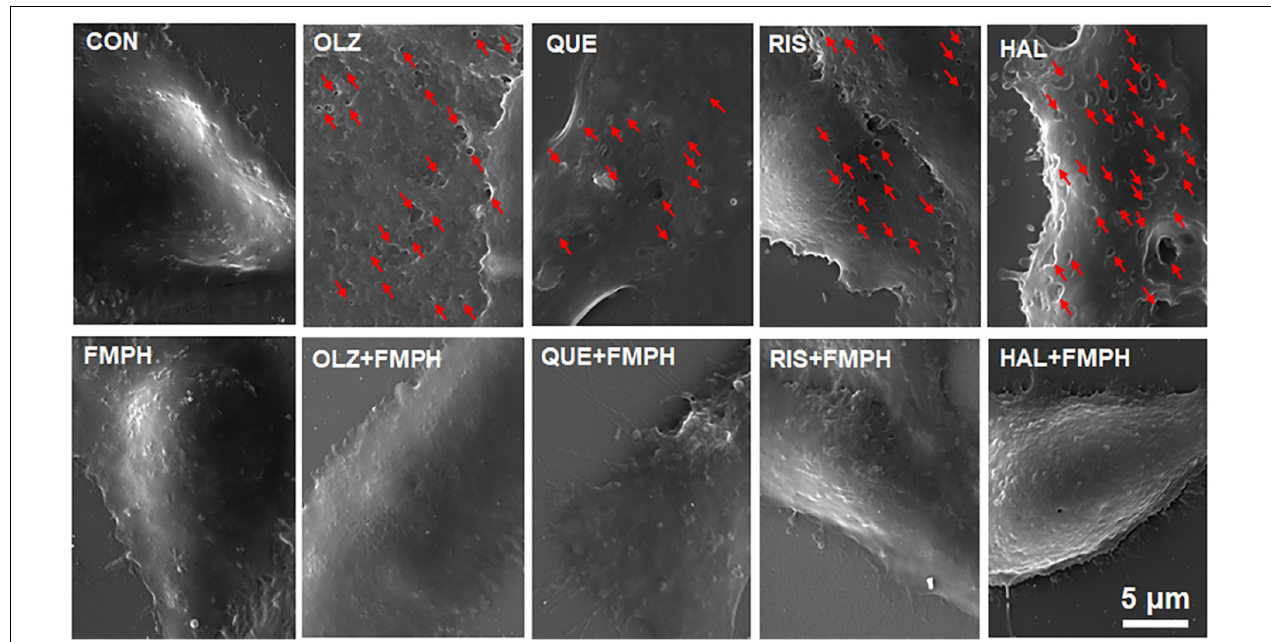
FIGURE 10 | 2-(3-Trifluoromethylphenyl) histamine (FMPH) inhibited antipsychotic-induced pore formation in the cell membrane. SEM Images of astrocytes treated with vehicle, antipsychotic drug (olanzapine/quetiapine/risperidone/haloperidol), or antipsychotic drug + FMPH 10 µ M were taken by a Tescan Vega-3 LMU emission scanning electron microscope operating at 20 kV. Red arrow indicates pores in the cell membrane. Con, control; OLZ, olanzapine; QUE, quetiapine; RIS, risperidone; HAL, haloperidol; FMPH,2-(3-Trifluoromethylphenyl)